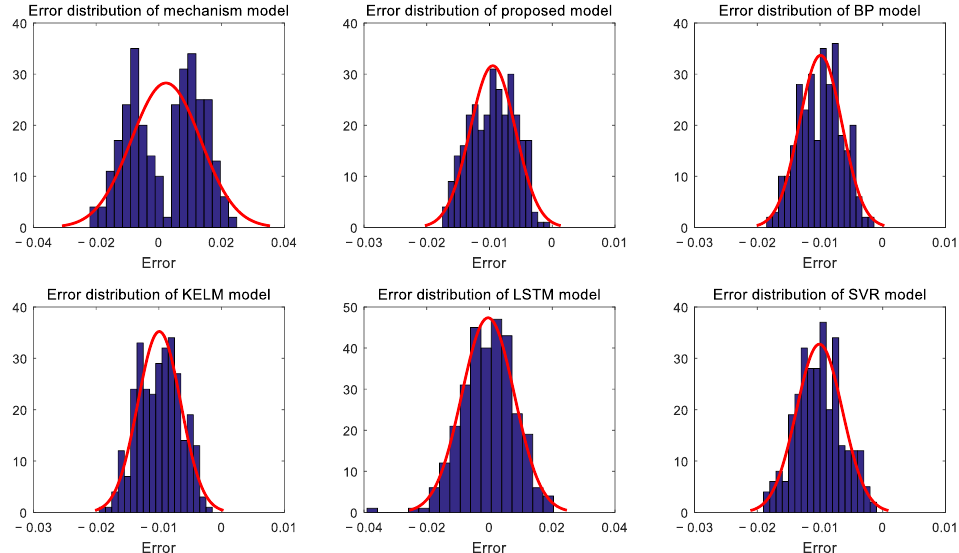
Figure 8. Error distribution of different prediction models when the data fluctuate smoothly.